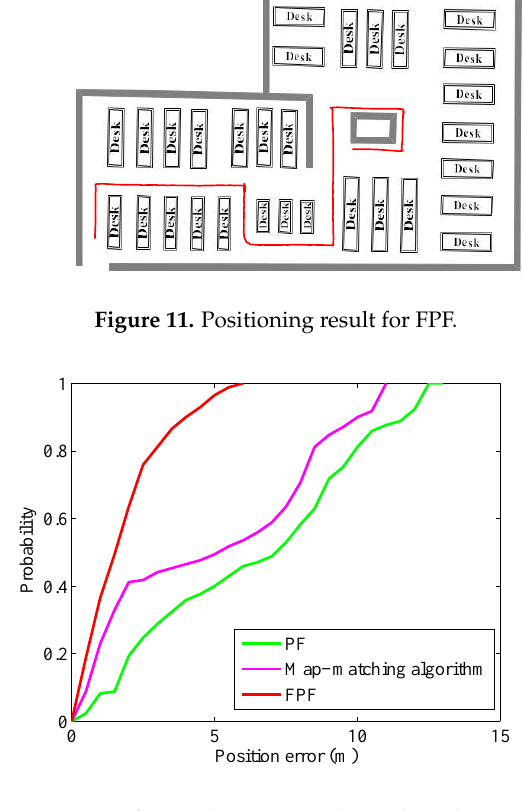
Figure 12. CDF for PF, the map-matching algorithm and